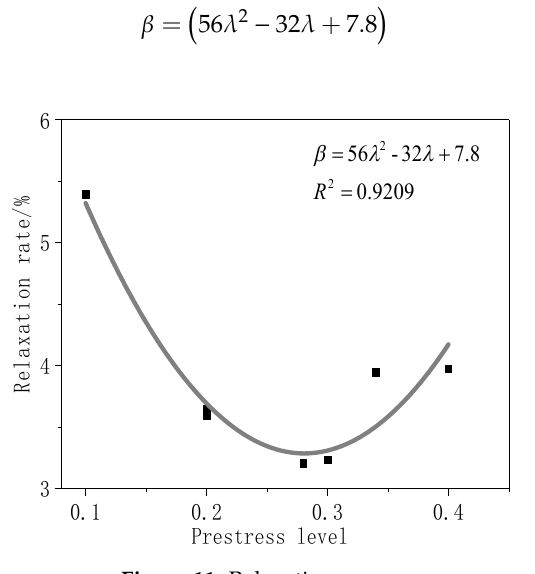
Figure 11. Relaxation curve.